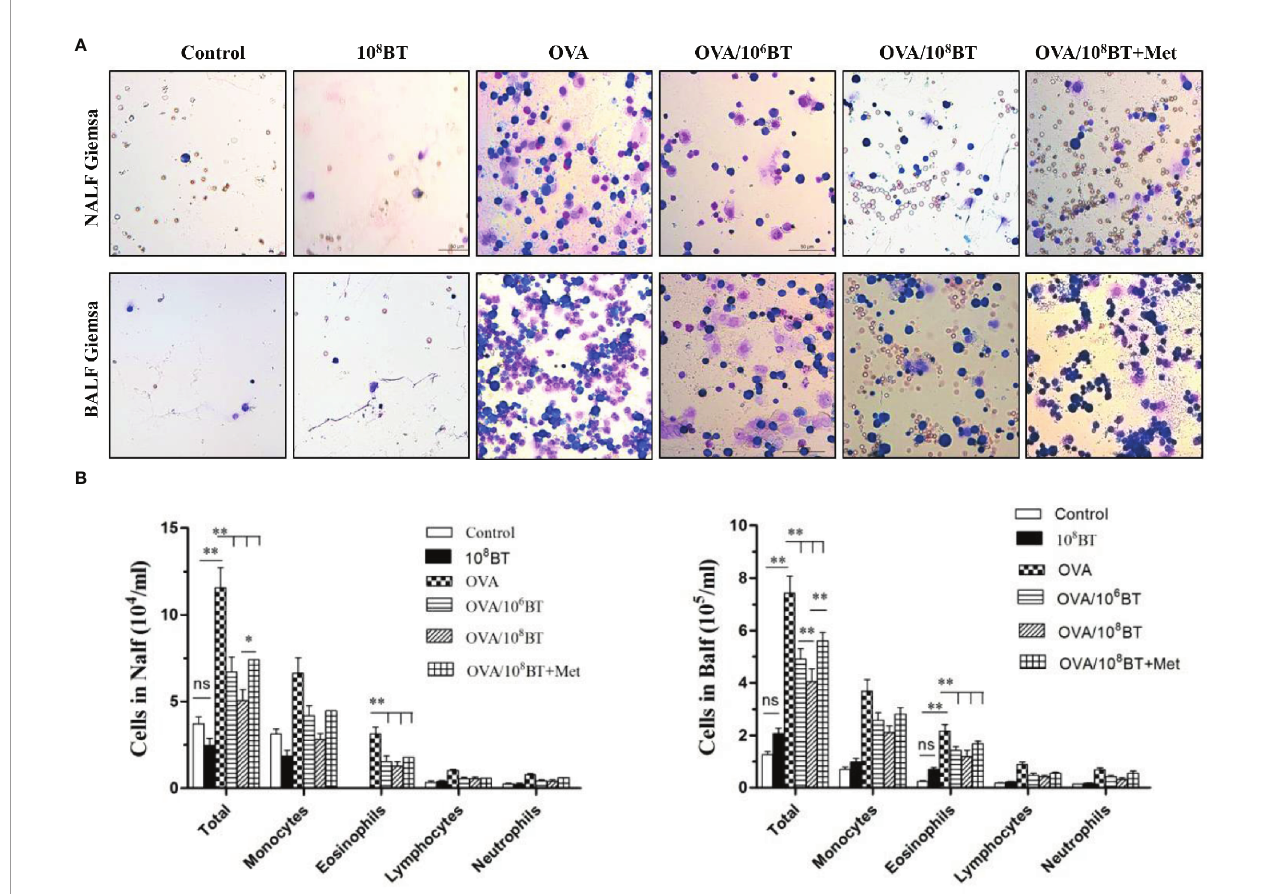
FIGURE 5 | OVA/BT inhibited OVA-induced airway in fl ammation. (A) Wright-Giemsa staining of in fl ammation cells in NALF and BALF at 24 h after fi nal challenge. (B) Total in fl ammation cells and eosinophils in NALF and BALF. Bar graphs represent mean ± SD.* P < 0.05, ** P < 0.01. ns, no signi fi